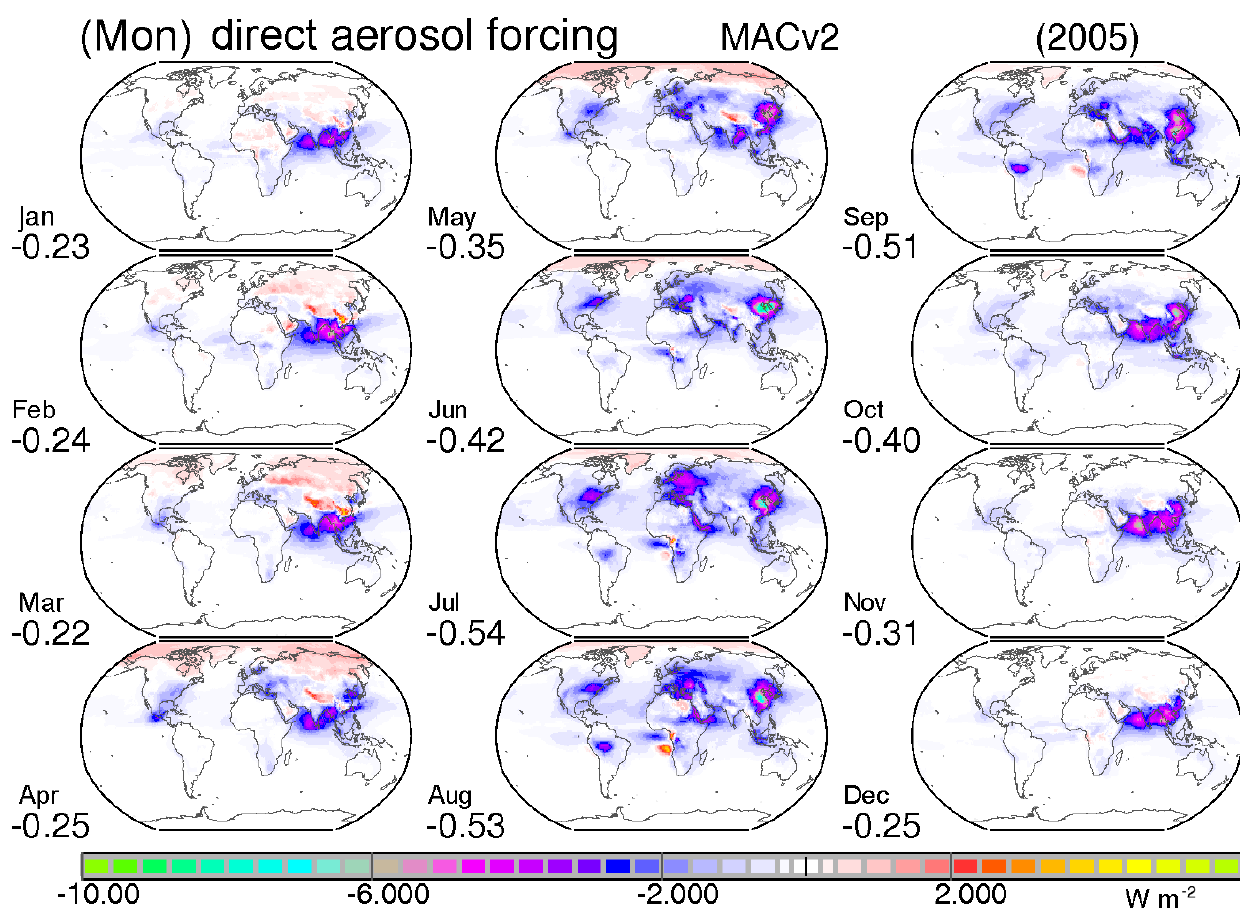
Figure 6. Monthly maps for present-day aerosol direct forcing with MACv2 aerosol properties.